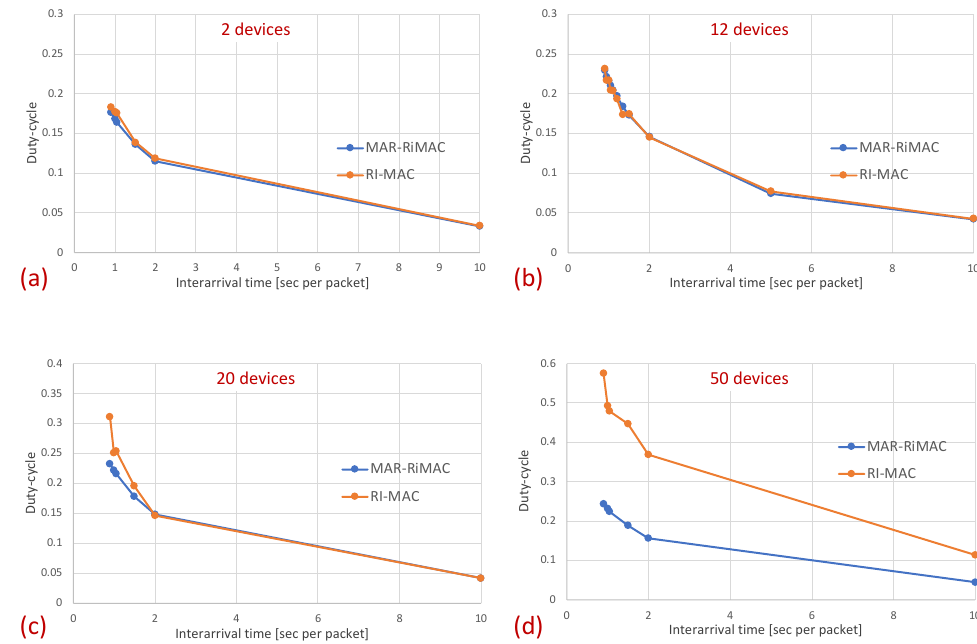
Figure 11. Hidden terminals: Mean duty-cycle for different numbers of devices and K = 4. ( a ) Two devices. ( b ) Twelve devices. ( c ) Twenty devices. ( d ) Fifty